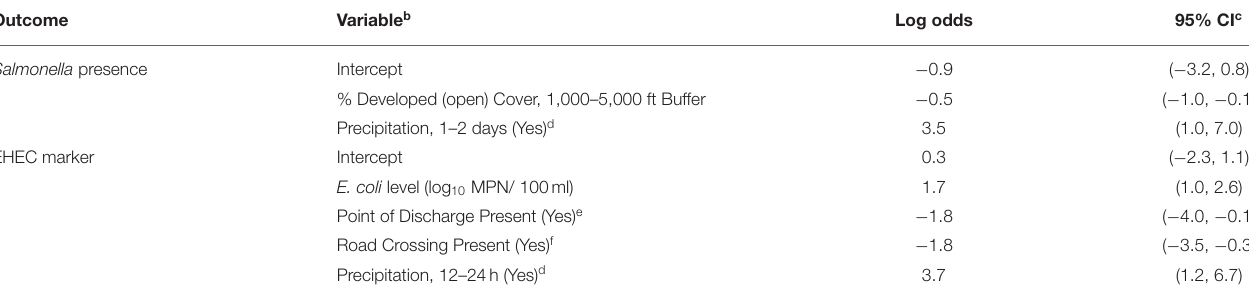
TABLE 2 | Results of mixed effects regression models a that characterize the relationship between pathogen detection ( Salmonella presence and EHEC marker detection) and environmental variables (e.g., land use, weather, sampling site characteristics, and water quality factors). Outcome Variable b Salmonella